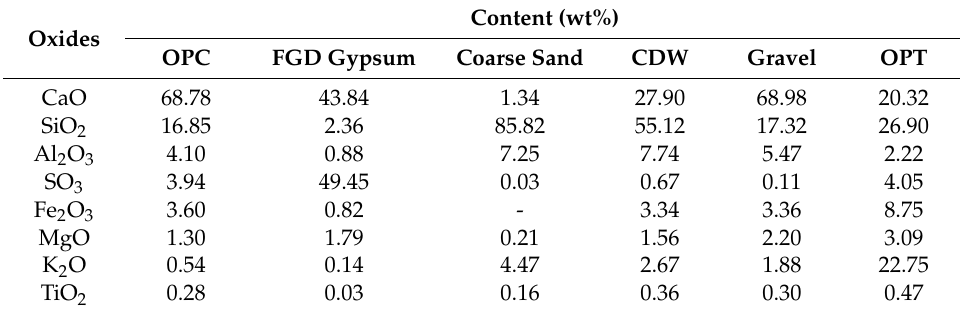
Table 2. Chemical properties of raw materials.